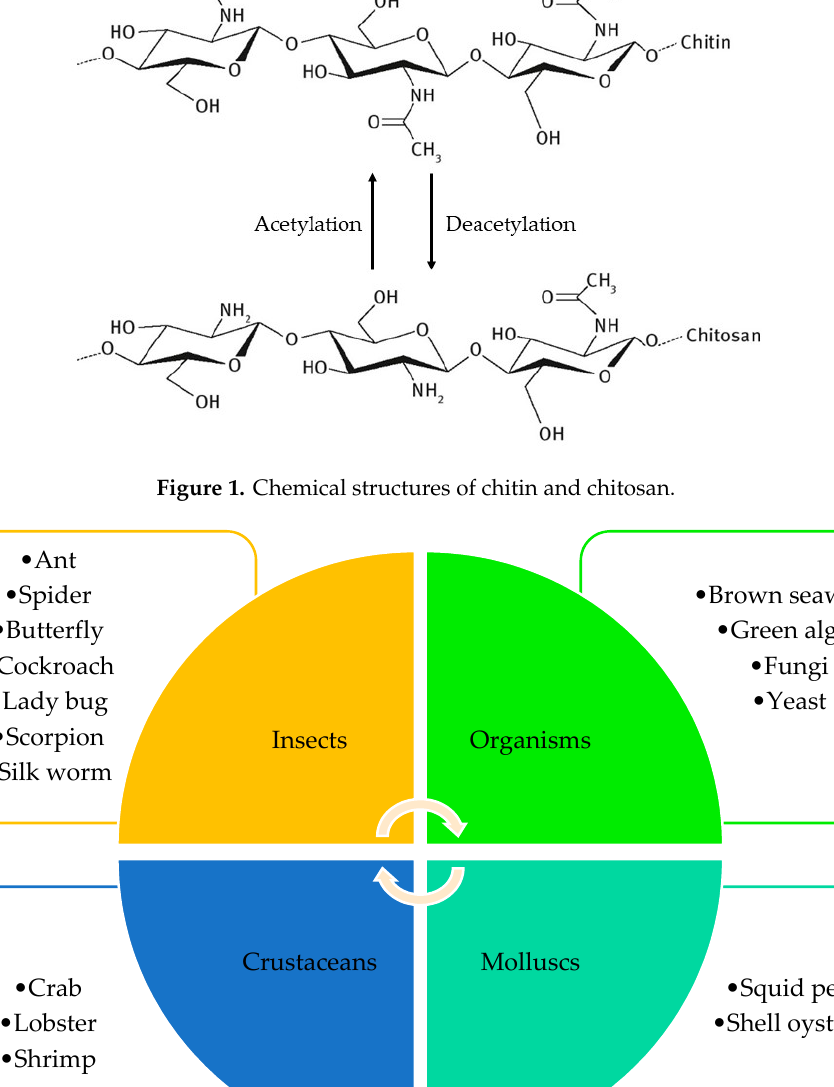
Figure 2. Sources of chitin production.